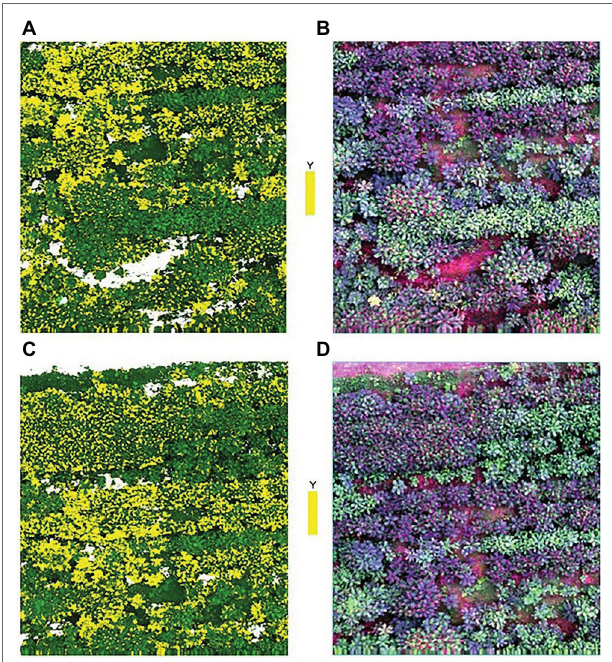
FIGURE 7 | Distribution of young leaves and old leaves of Toona sinensis in the prediction map and the original map. Y, young leaves; (A) Prediction map of the original image 1; (B) Original image 1; (C) Prediction map of the original image 2; (D) Original image